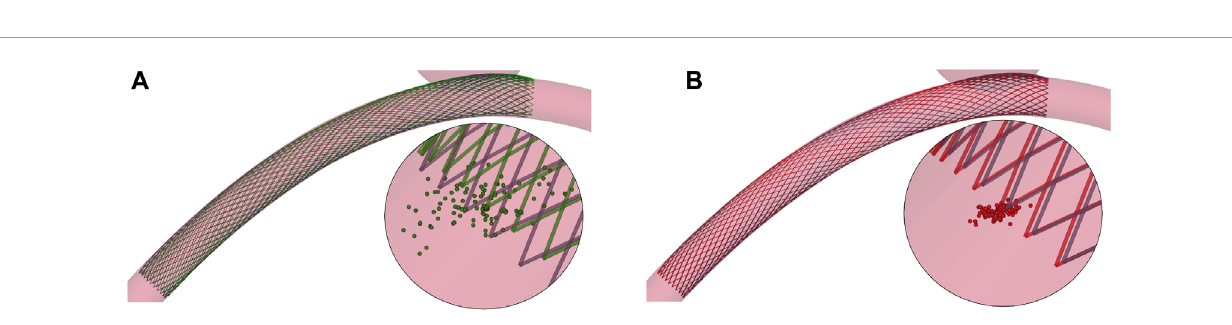
FIGURE 8 Two examples from the test dataset: focus on 100 points sampled within the multivariate normal distribution predicted by the GPR for the displacement of the first node of the stent mesh. (A) HF (black) and predicted (green) solution using μ B as predictors. (B) HF (black) and predicted (red) solution using μ cl as